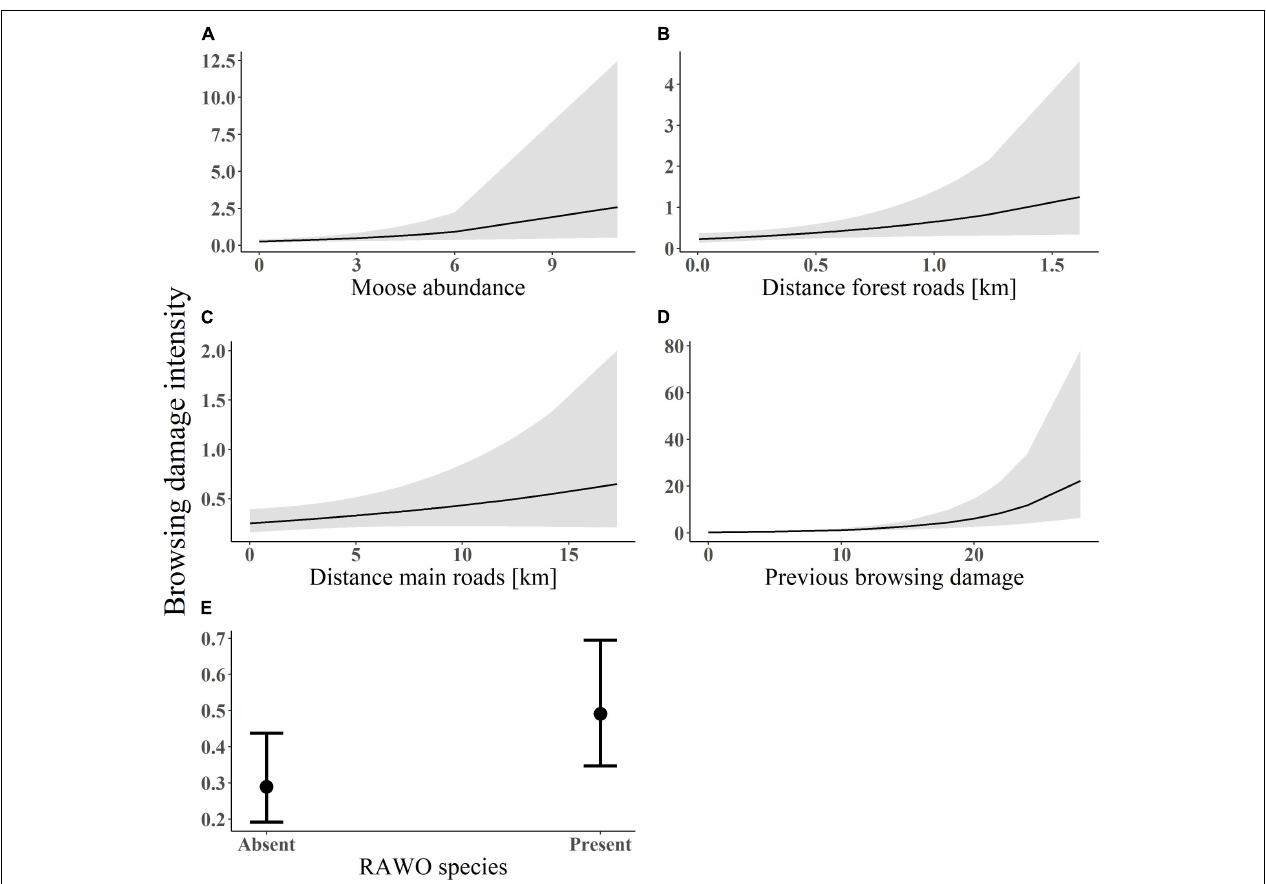
FIGURE 4 | Predicted values of browsing damage intensity (number of damaged stems per plot) in relation to (A) moose abundance; (B) distance from forest roads; (C) distance from main roads; (D) previous browsing damage; and (E) RAWO presence. Data on browsing damage was collected within south-central Sweden between 2003 and 2016. The lines in figure A–D indicate the fitted values with associated standard errors from the model-averaged estimates. Plot (E) shows the coefficients and confidence intervals of the predicted values of browsing damage intensity in relation to presence/absence of RAWO (rowan, aspen, willow and oak)